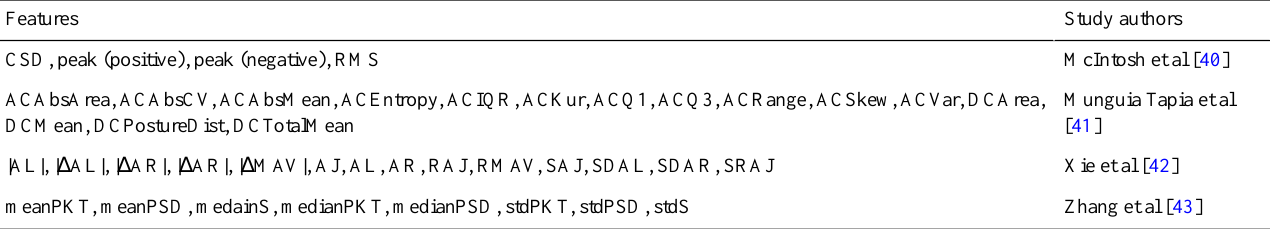
Table 2. Features are extracted from acceleration, gyroscope, orientation, and surface electromyography